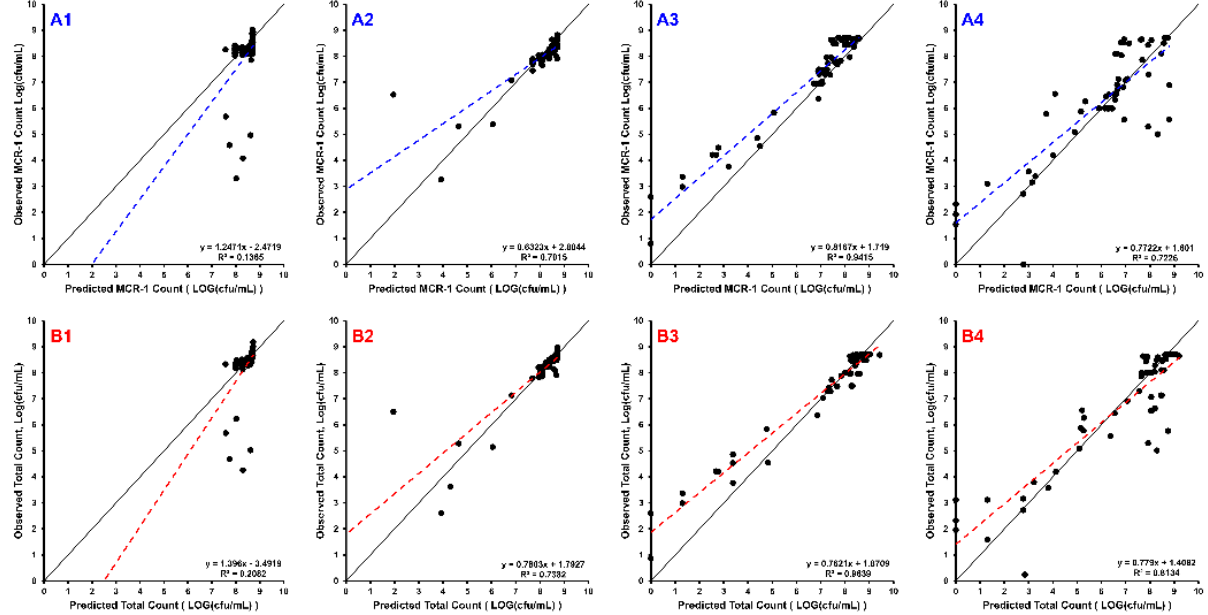
Figure 2. The line of identity (solid black) is overlain with the linear regression of the data (dashed line). Each row of sub-plots was divided so that B1 – B4 are the observed vs. predicted plots for the total bacterial population (WT + mcr1a), and A1 – A4 are the plots for mcr1a-only cells as determined by plating on kanamycin-containing plates. Each column of subplots represents the starting proportion of WT:mcr1a at the beginning of the experiment: 99% WT:1% mcr1a ( A1 , B1 ), 90% WT:10% mcr1a ( A2 , B2 ), 50% WT:50% mcr1a ( A3 , B3 ), and 10% WT:90% mcr1a ( A4 , B4 ).